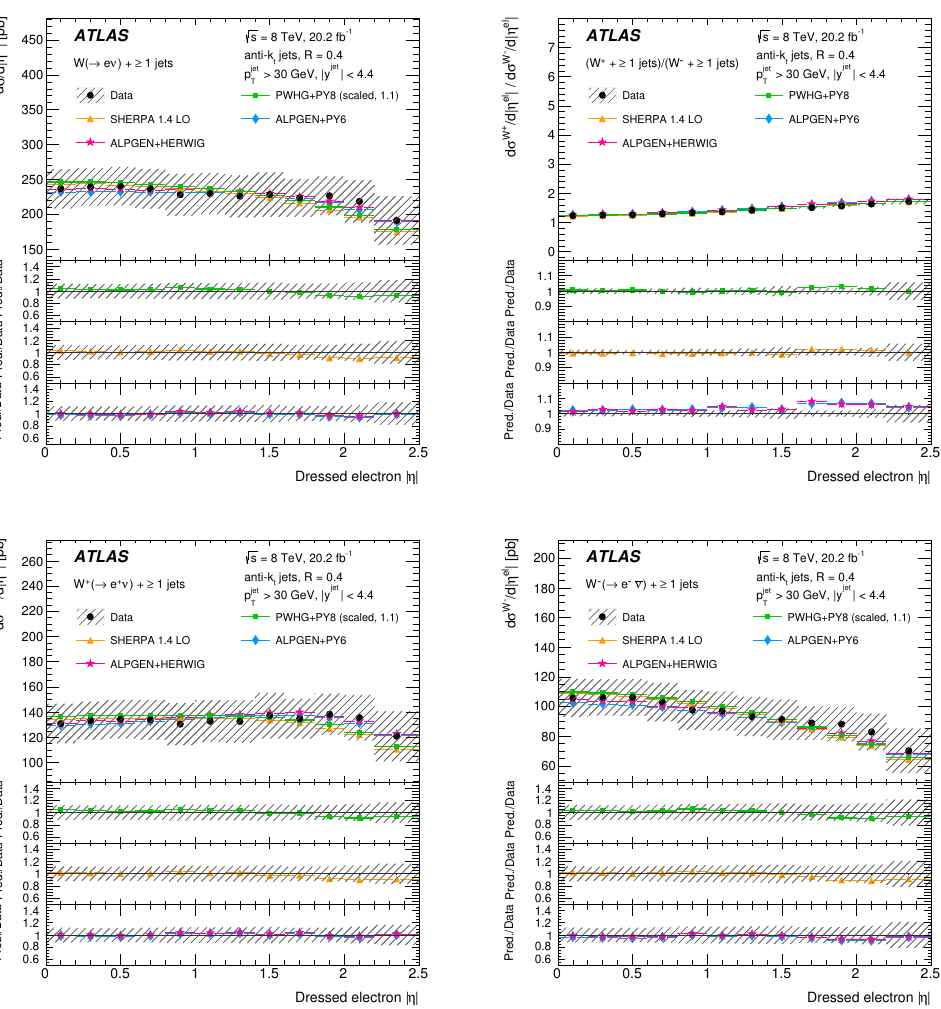
Figure 15 . Di(cid:11)erential cross sections for the production of W bosons (top left), W + (bottom left), W (cid:0) (bottom right) and the W + =W (cid:0) ratio (top right) as a function of the electron (cid:17) for events with N jets (cid:21) 1. For the data, the statistical uncertainties are indicated as vertical bars, and the combined statistical and systematic uncertainties are shown by the hatched bands. The uppermost panel in each plot shows the di(cid:11)erential cross sections, while the lower panels show the ratios of the predictions to the data. The theoretical uncertainties on the predictions are described in the text. The arrows on the lower panels indicate points that are outside the displayed